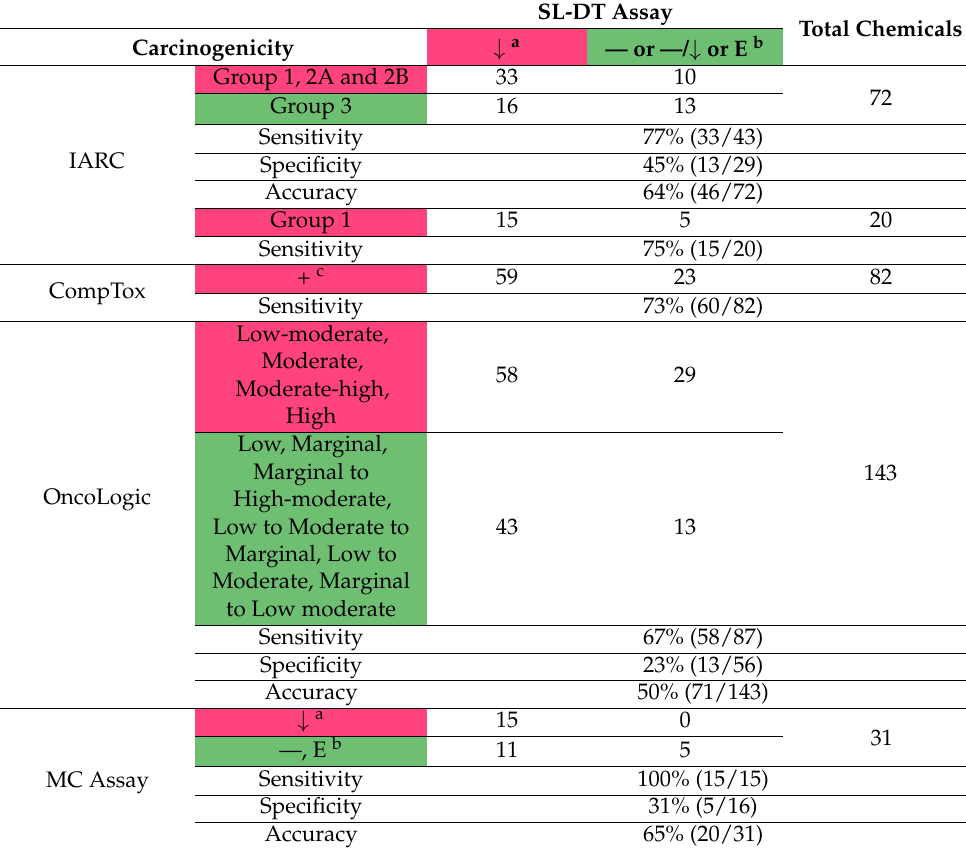
Table 3. Comparison between carcinogenicity evaluated by the IARC, CompTox, OncoLogic or the metabolic cooperation (MC) and the SL-DT assay in WB-F344 cells. In the table, number of assessed chemicals are given, and the SL-DT assay sensitivity and (if applicable) specificity and accuracy (%) are provided. Raw data are provided in the Supporting